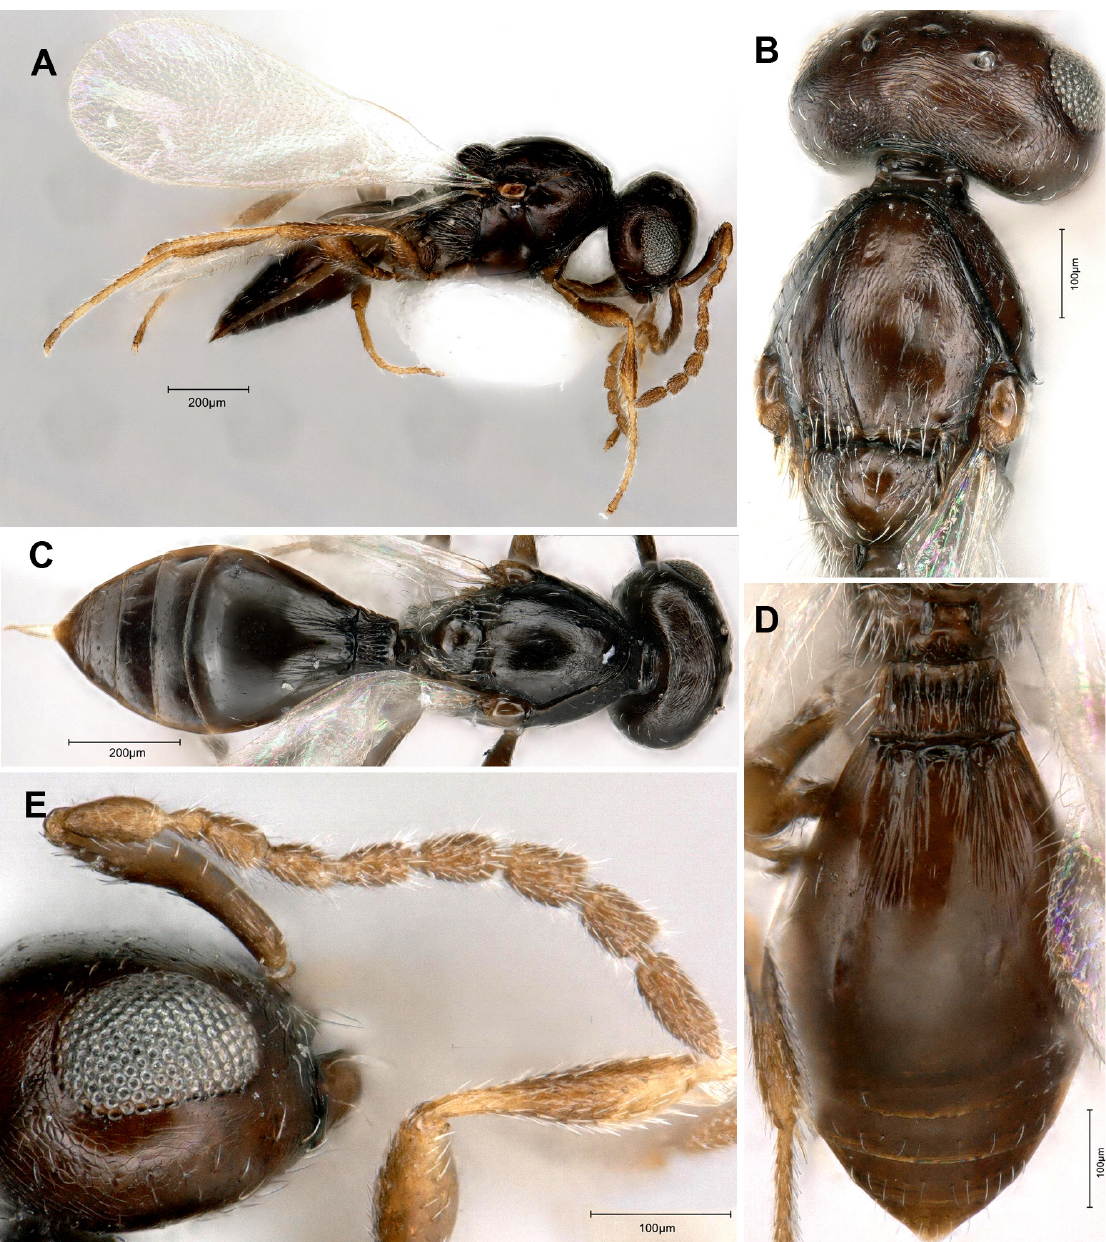
Fig. 1. Platygaster azarbaijanica Buhl & Asadi sp. nov., ♀; A, C, E = holotype (HMIM); B, D = paratype (HMIM). A . Habitus in lateral view. B . Head and mesonotum in dorsal view. C . Habitus in dorsal view. D . Metasoma in dorsal view. E . Head and antenna in lateral view. Scale bars: A, C =200 µm; B, D–E = 100